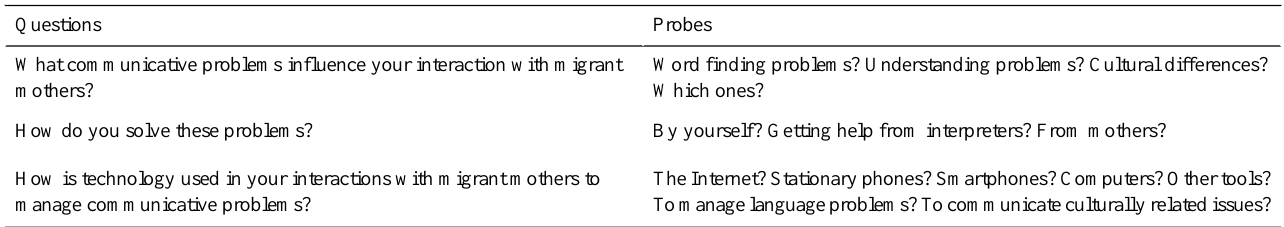
Table 1. Interview